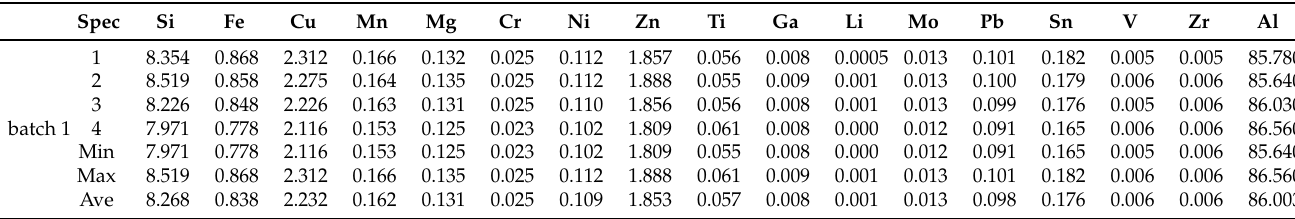
Table 1. Chemical composition of alloy